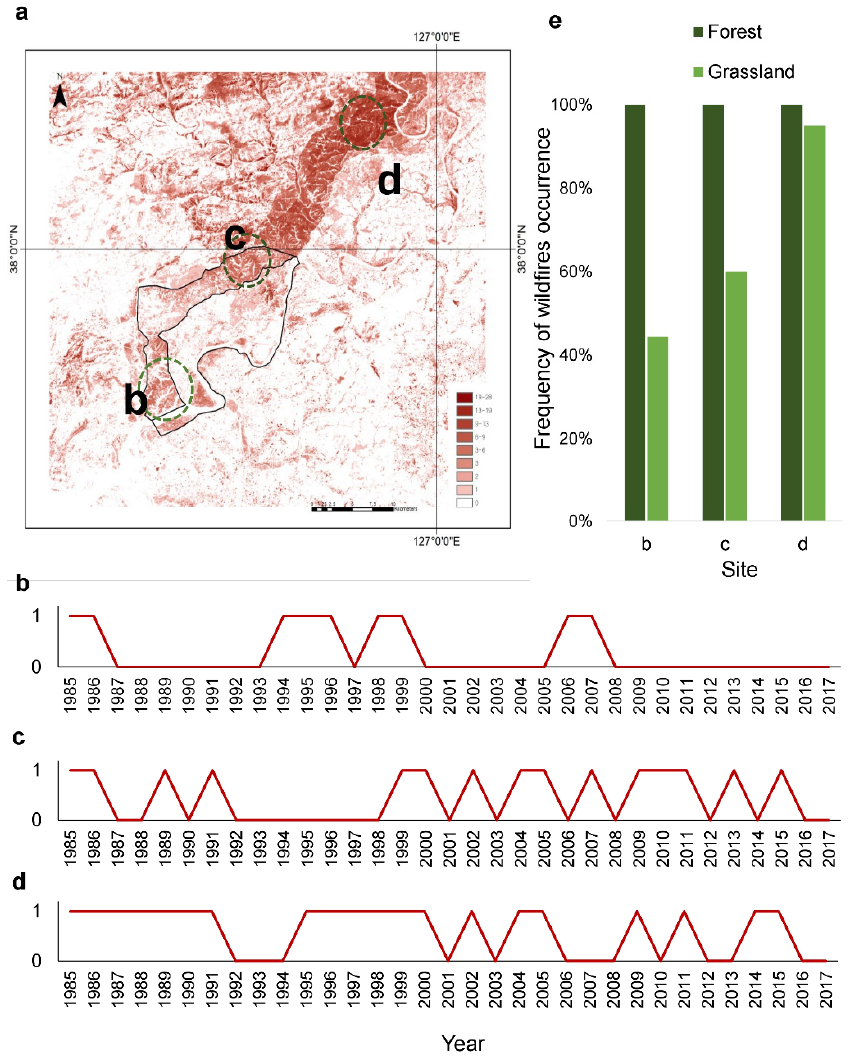
Figure 7. Wildfire outbreaks in western DMZ and CCZ from 1985 to 2017. ( a ) Cumulative map of number of wildfires. ( b ) Wildfires from 1985 to 2017 in Region b. Fires in Region b mainly occurred in forests, followed by grasslands. Note: 1, fire outbreak. ( c ) Wildfires from 1985 to 2017 in Region c. This area is inland and, unlike Region b, wetlands were not developed. ( d ) Wildfires from 1985 to 2017 in Region d. Region belongs to Yeoncheon-gun, and fires were frequent. ( e ) Frequency of wildfires on different vegetation types in Regions b–d.